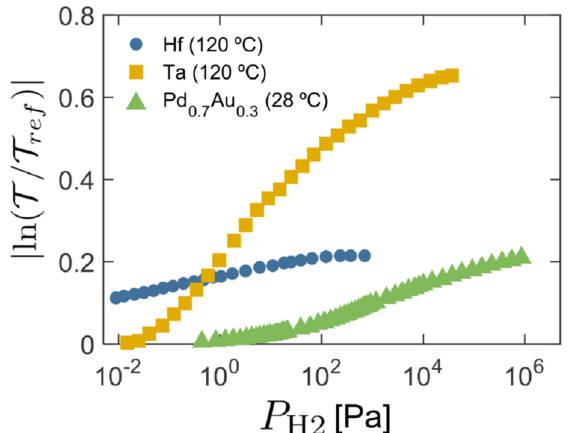
Figure 4. Optical contrast over a wide H 2 concentration for a Pd-capped Hf and Ta thin films, in comparison to the contrast exhibited by a Pd 70 Au 30 film of similar thickness. In the cases of the Pd-capped Ta and the Pd 70 Au 30 thin films, a 4-nm Ti layer is used as an adhesion layer. Reproduced from [67], with permission from Elsevier, 2019.